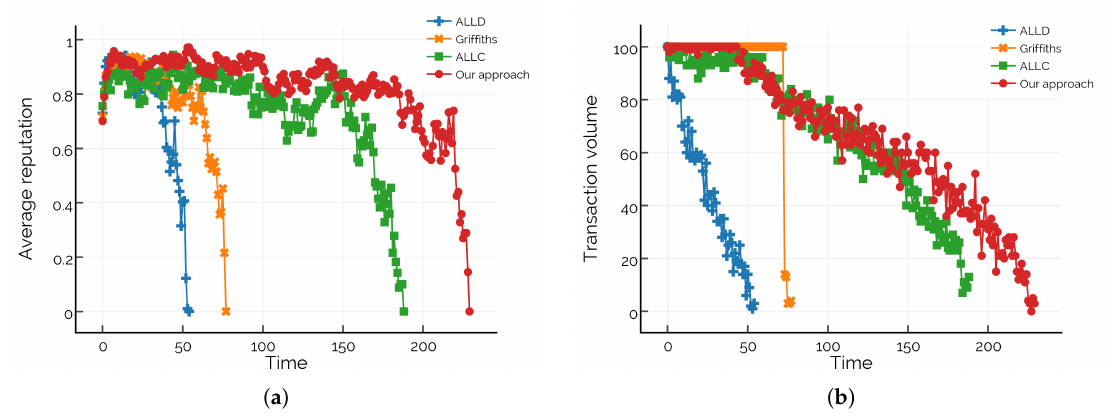
Figure 2. ( a ) Average reputation values; ( b ) Transaction volumes at different time periods.